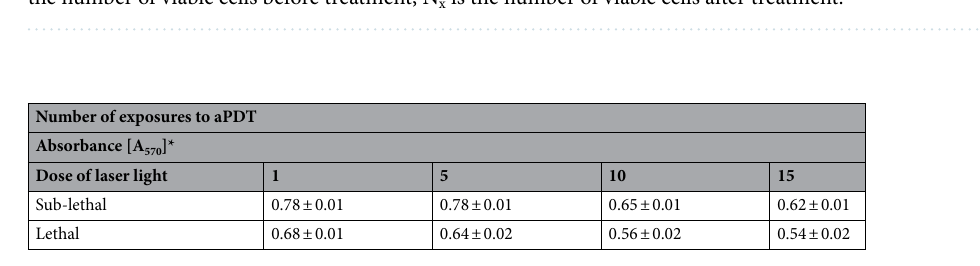
Table 2. The effect of multiple photosensitization on the efficiency of biofilm formation by A.baumannii. *Mean value of three replicates.